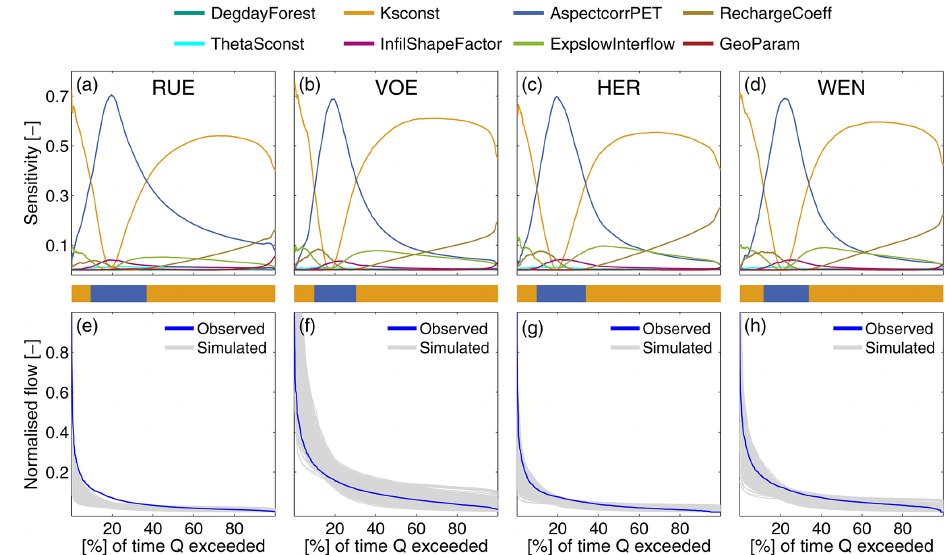
Figure 6. (a–d) Sensitivity of eight global mHM parameters along streamflow exceedance probability (flow duration curve, FDC) for four Ruhr headwater catchments RUE, VOE, HER, and WEN. Catchment-specific strips show the parameters with the highest sensitivity along the FDC. (e–h) Observed flow duration curves and the corresponding ensembles of each 243 simulated FDCs for the period 2002 to 2006, normalised by the highest streamflow value observed at each of the four headwater